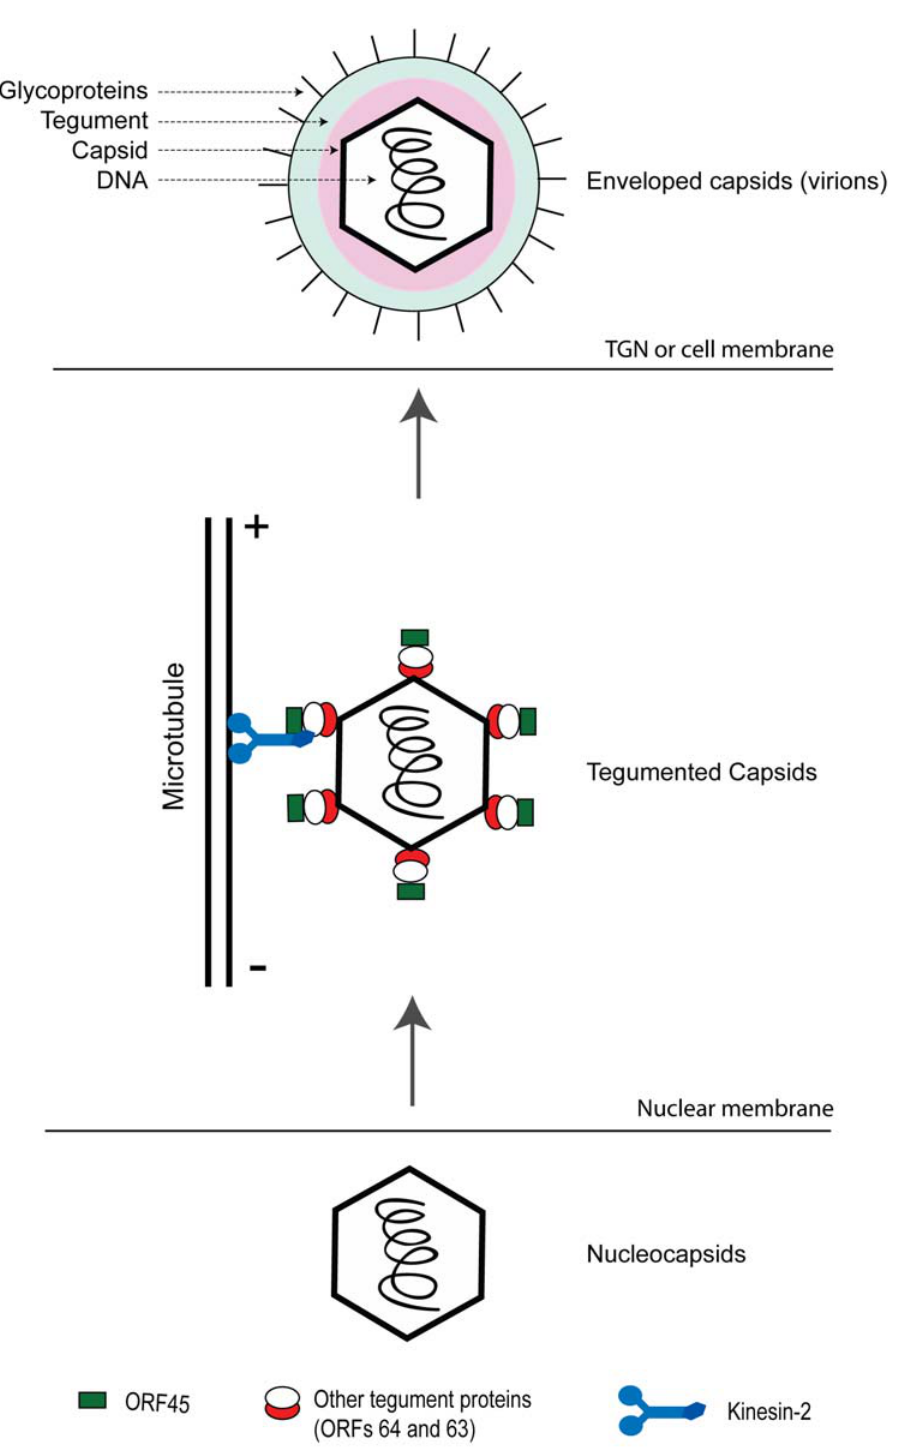
Figure 8. Model for transport of KSHV capsid-tegument complexes following viral reactivation. Newly synthesized nucleocapsids exit out of the nuclear compartment wherein they acquire the tegument proteins including ORF45. ORF45 on the viral particles binds to KIF3A, docking the entire viral capsid-tegument complexes onto it. The complexes are then transported along microtubules either to trans-Golgi vesicles (TGN) or cell membrane for further envelopment and viral egress.